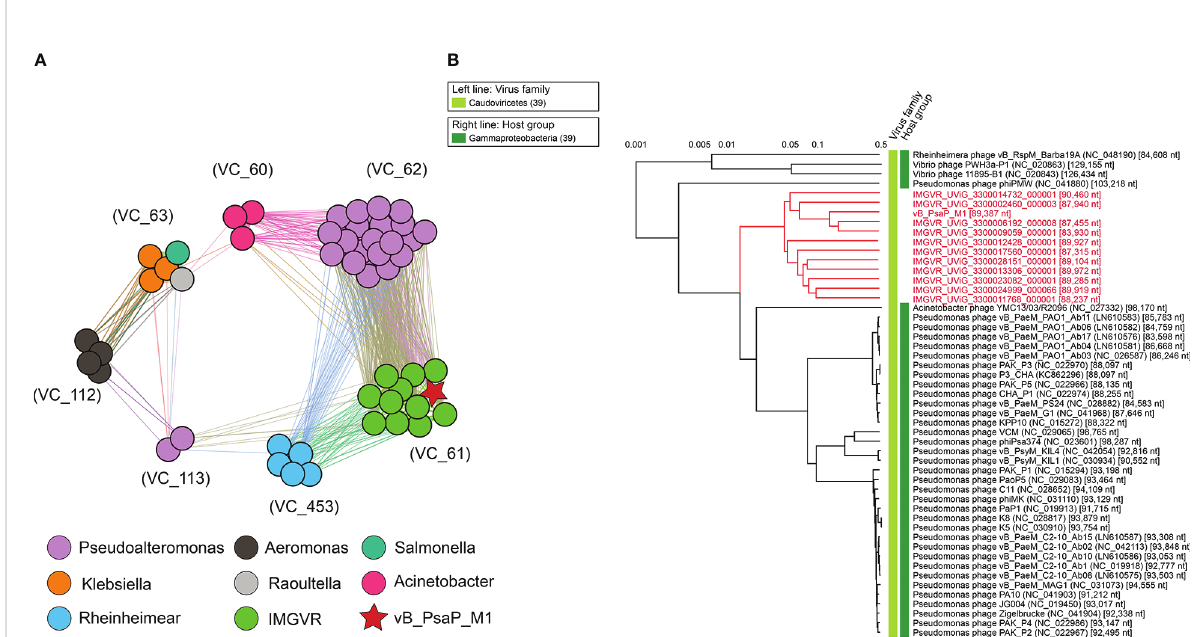
FIGURE 6 (A) vB_PsaP_M1,virus from NCBI RefSeq database, and related environmental viral sequences from Integrated Microbial Genomes/Virus (IMG/ VR). Different colors of nodes represent different kinds of viruses. Edges represent similarity scores between genomes. VCs are generated by